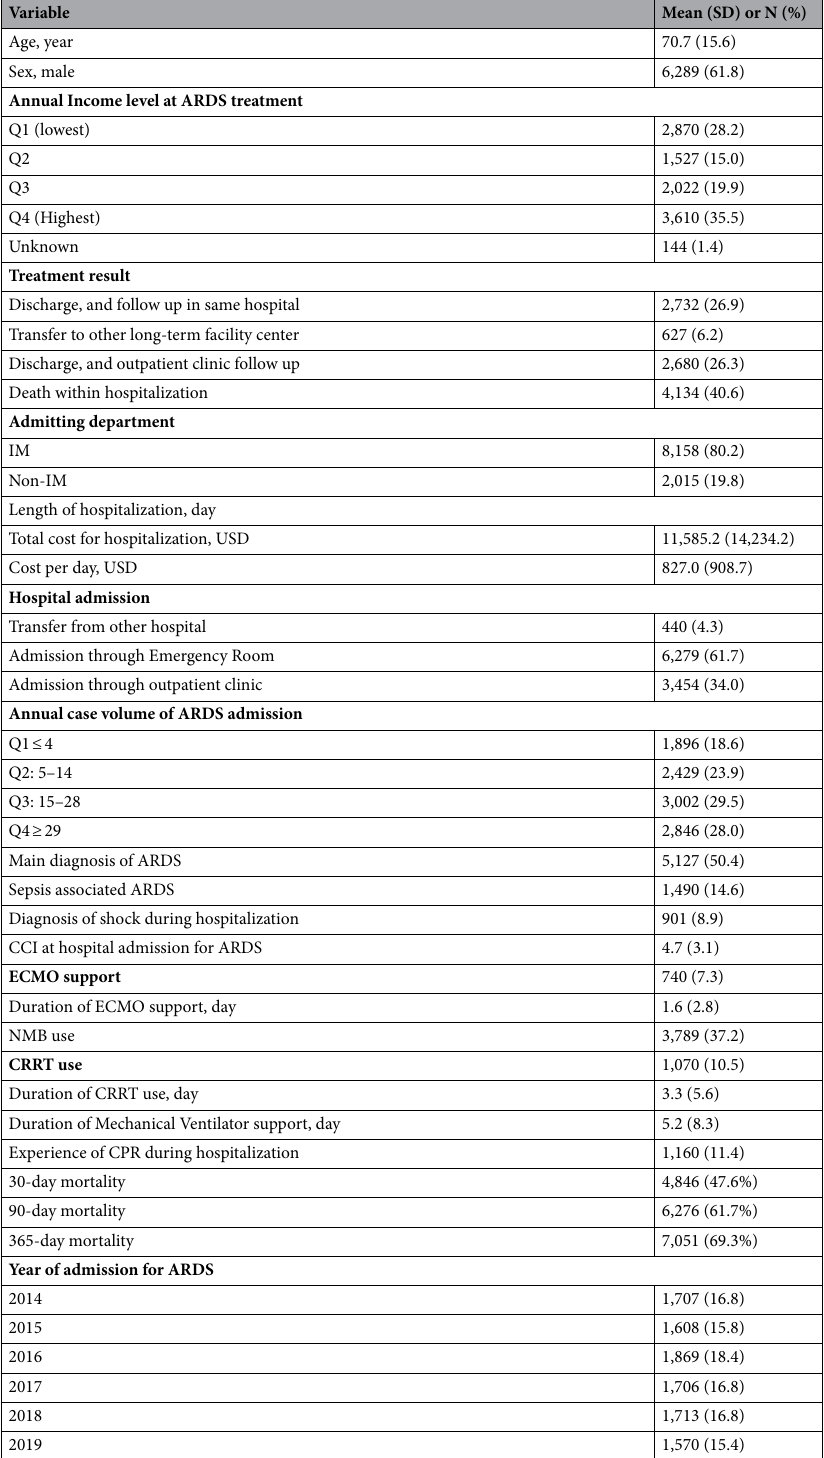
Table 1. Clinicopathological characteristics of all ARDS’ patients. ARDS, acute respiratory distress syndrome; SD, standard deviation; IM, internal medicine; USD, United States Dollars; ECMO, extracorporeal membrane oxygenation; NMB, neuromusclar blockade; CRRT, continuous renal replacement therapy, CPR, cardiopulmonary